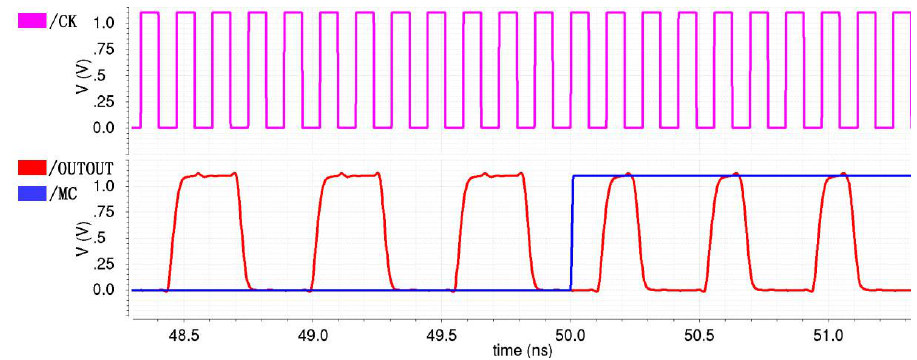
Figure 5. Simulation results of the proposed prescaler operating at 7.2 GHz @ 1.1 V supply and room temperature. Table 2. Performance of different structure of frequency dividers